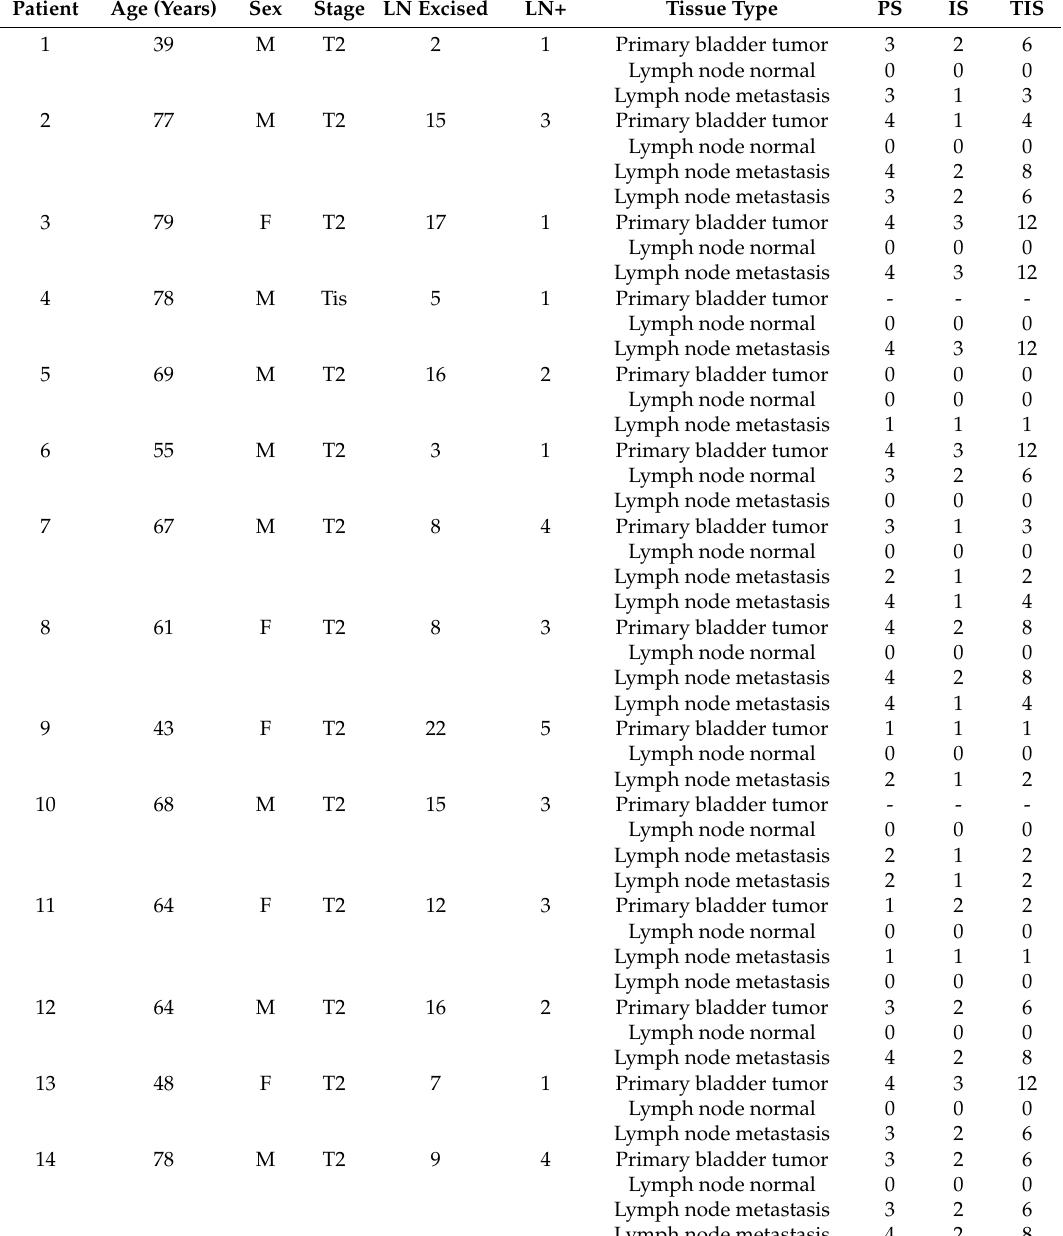
Table 1. Scoring EpCAM